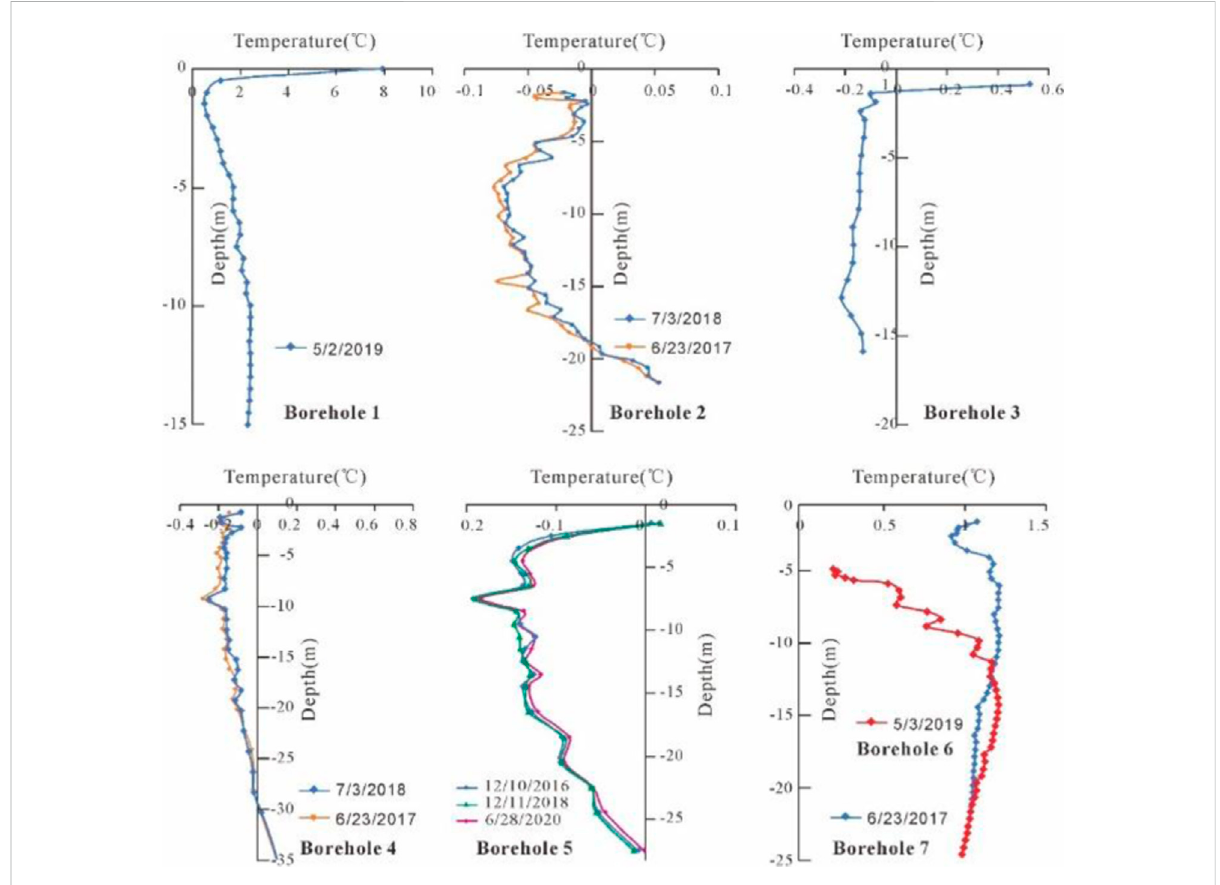
FIGURE 4 Mahan Mountain borehole temperature measurement